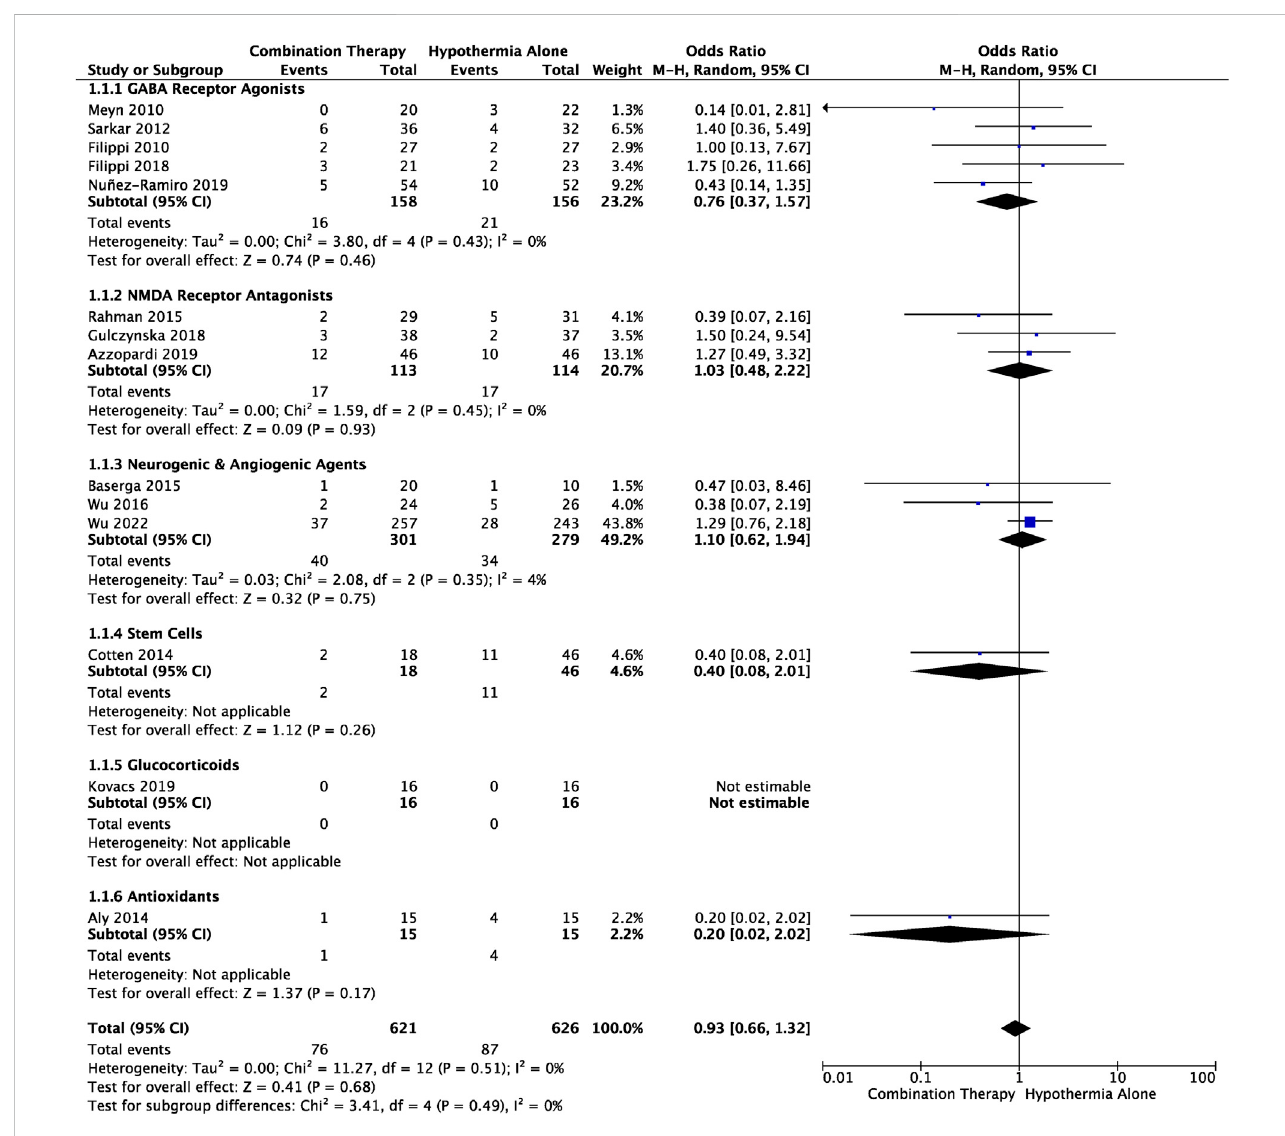
Forest plot of mortality in HIE infants treated with combination therapy compared to TH alone. An OR < 1 suggests combination therapy is more favourable to reduce the risk of mortality. Timepoint at which mortality was assessed is outlined in Table 1. OR .93, 95% CI [.66 to 1.32], p =